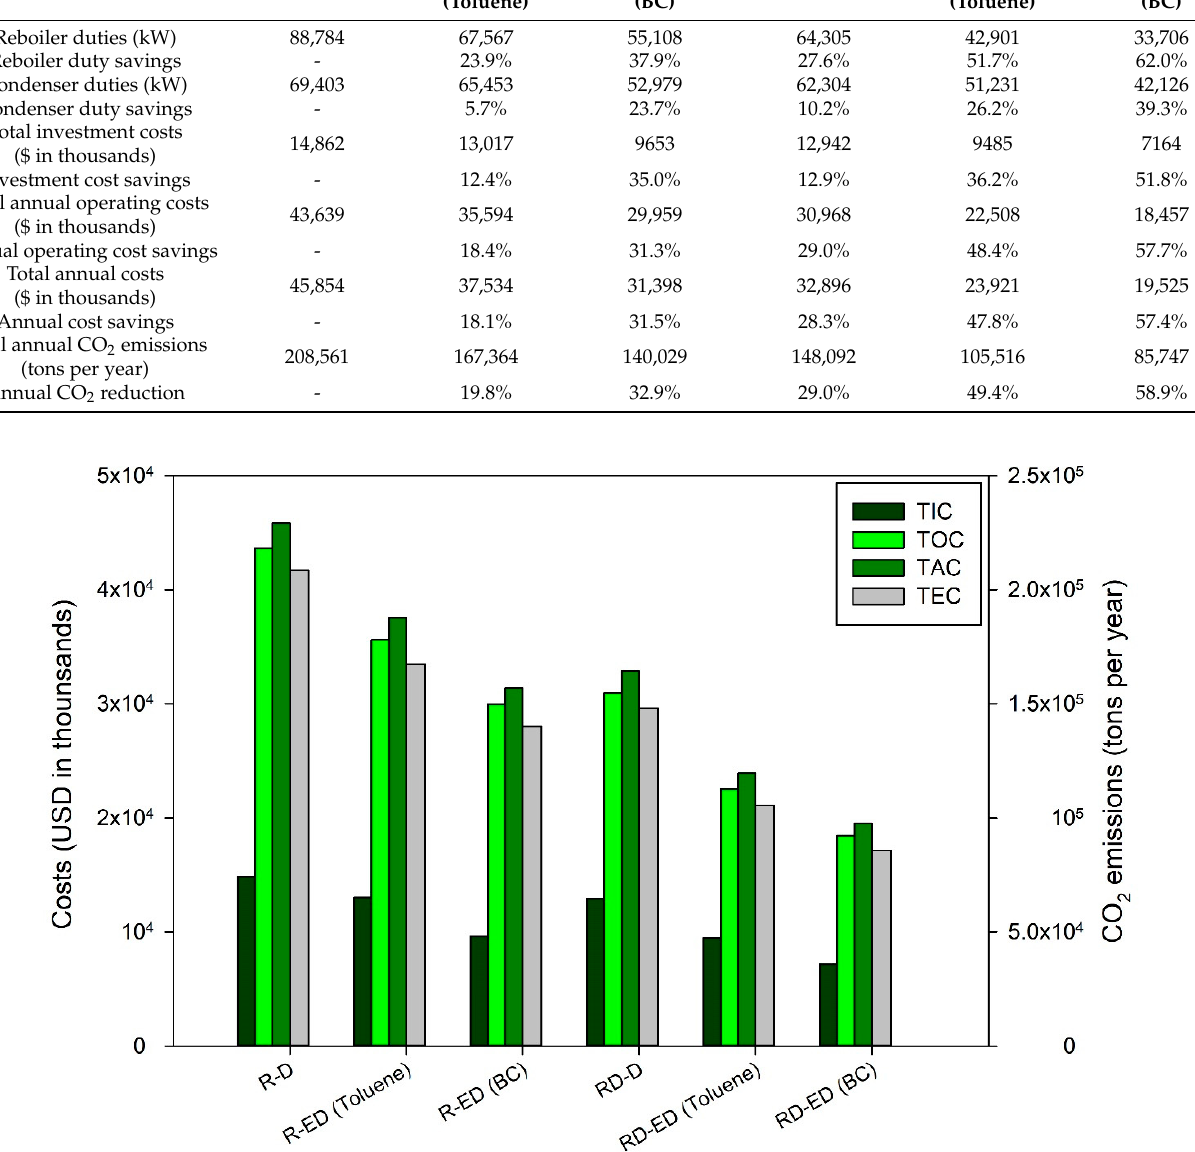
Figure 9. Economic and environmental evaluations of all structural alternatives for furfural production process.